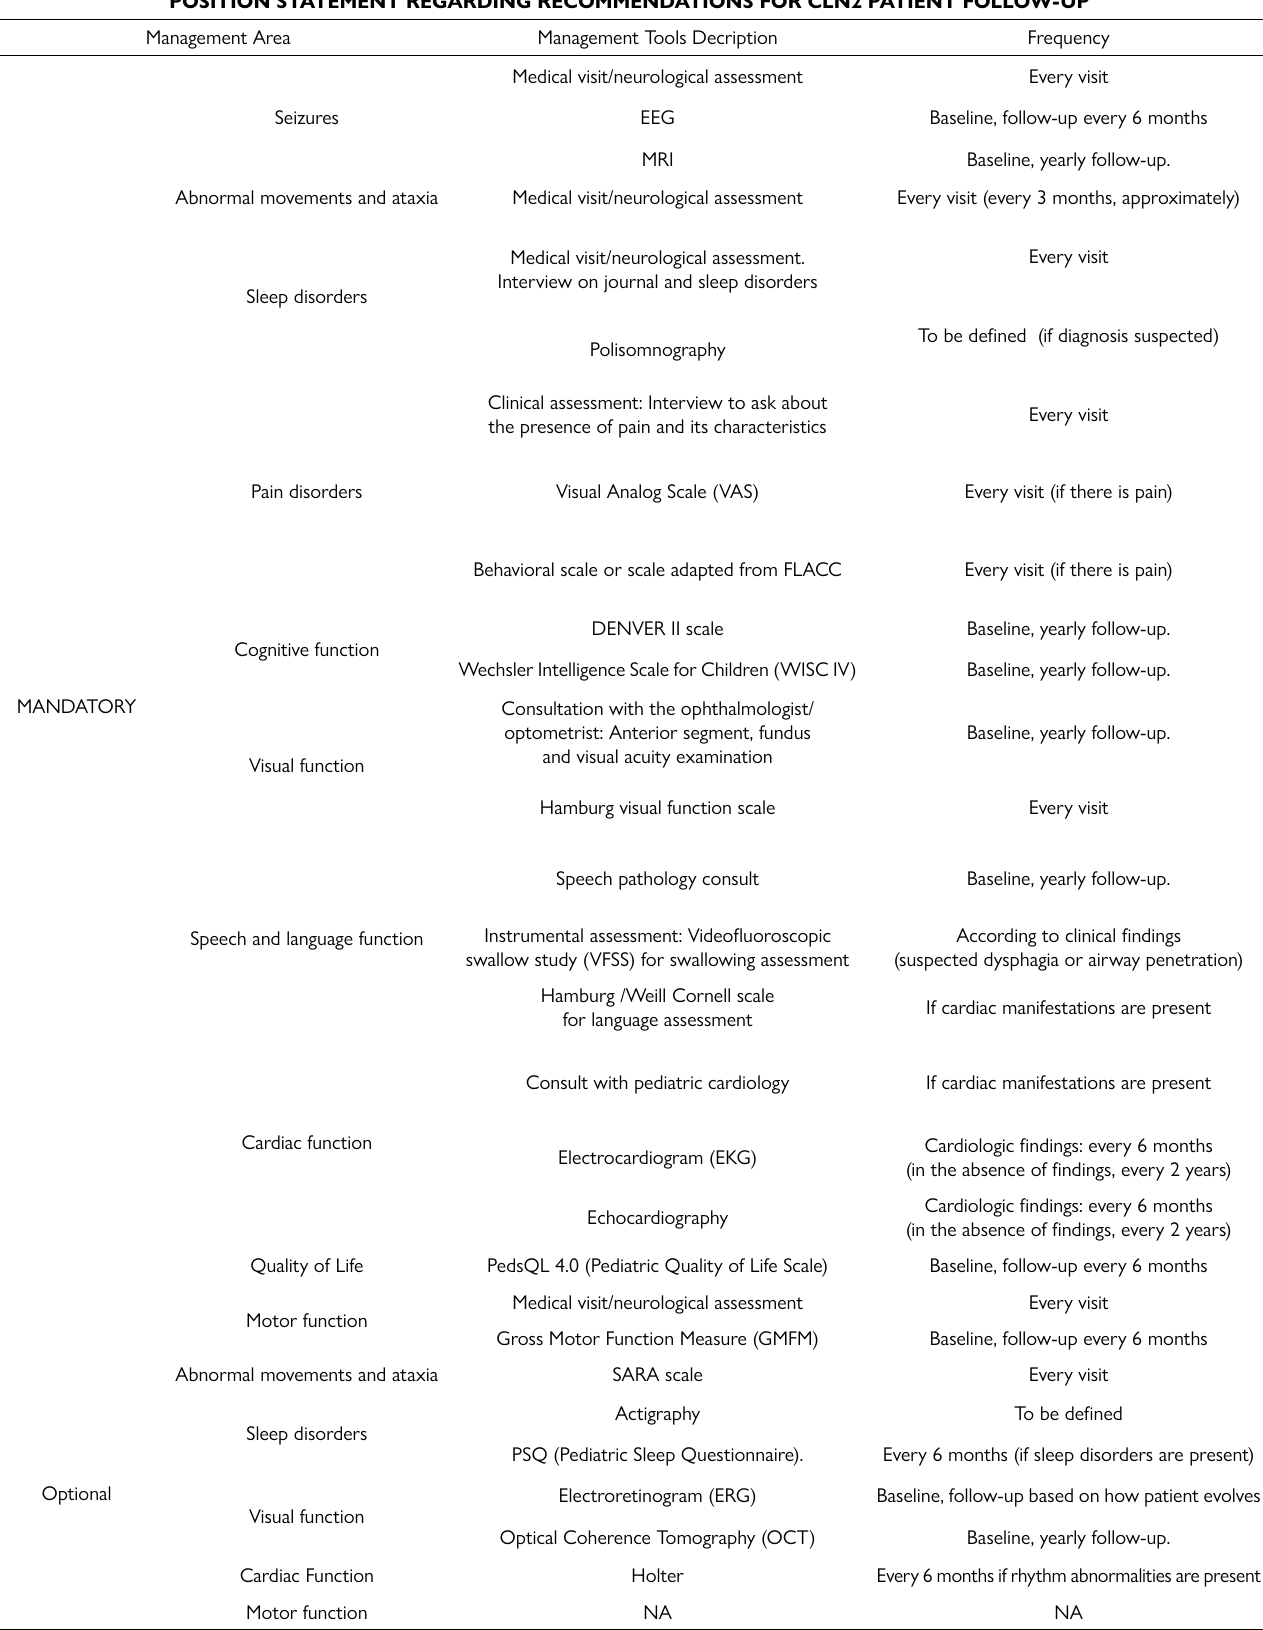
Table 1. Summary of recommendations for follow up in patients with CLN2 disease. POSITION STATEMENT REGARDING RECOMMENDATIONS FOR CLN2 PATIENT